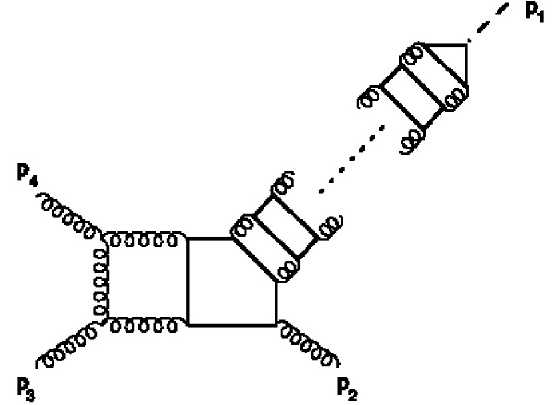
Figure 27. Planar All-loop diagram contributing to H + j